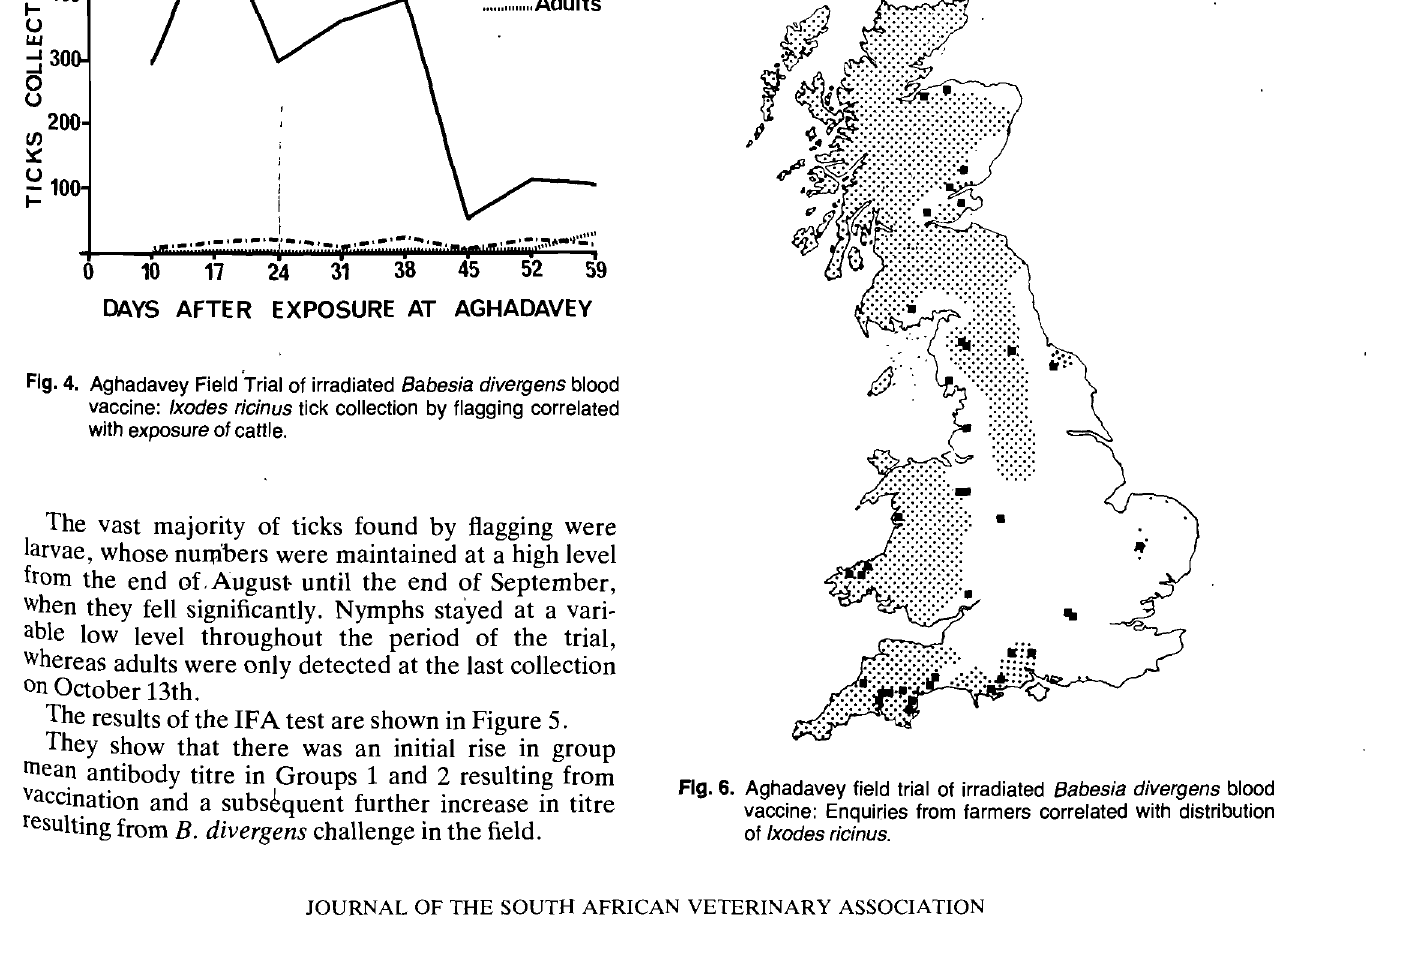
Fig. 4. Aghadavey Field 'Trial of irradiated Babesia divergens blood vaccine: Ixodes ricinus tick collection by flagging correlated with exposure of cattle.